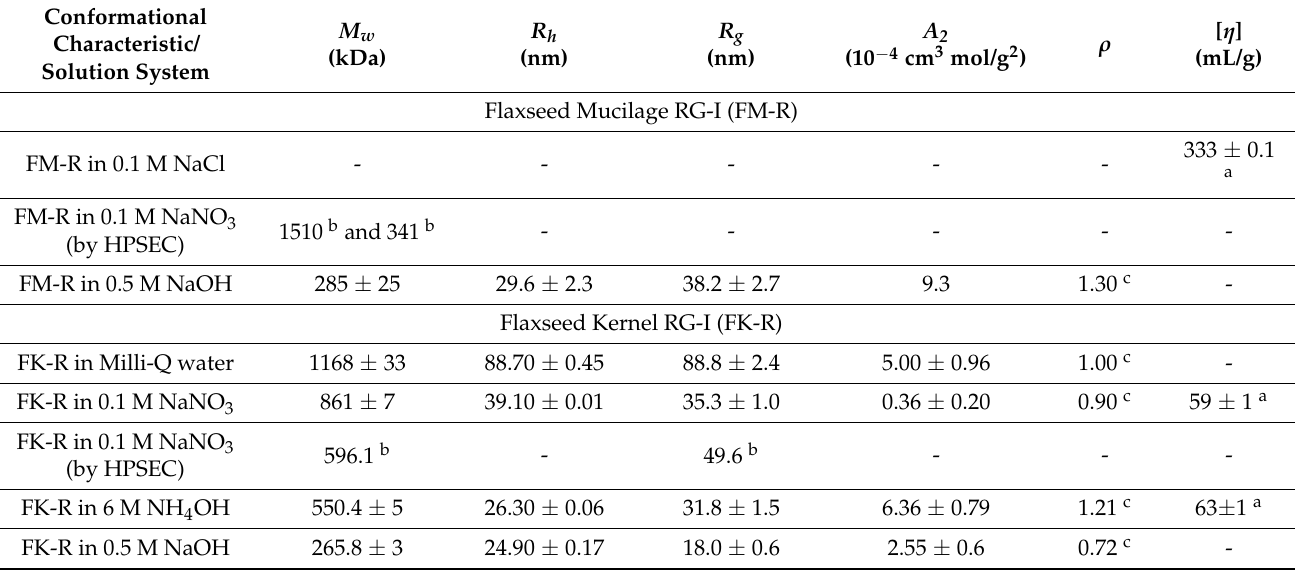
Table 1. Conformational characteristics of flaxseed kernel RG-I (FK-RGI) and flaxseed mucilage RG-I